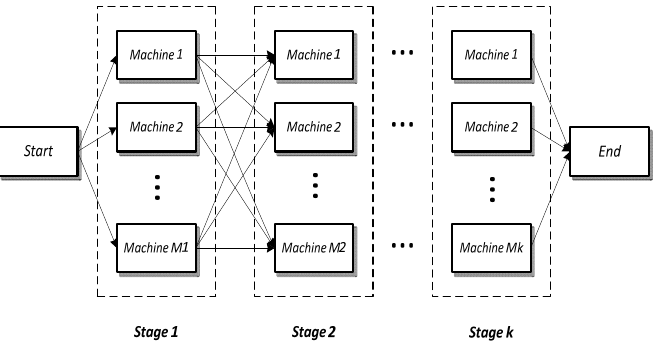
Fig. 1. The hybrid flowshop scheduling environment (Kurdi,